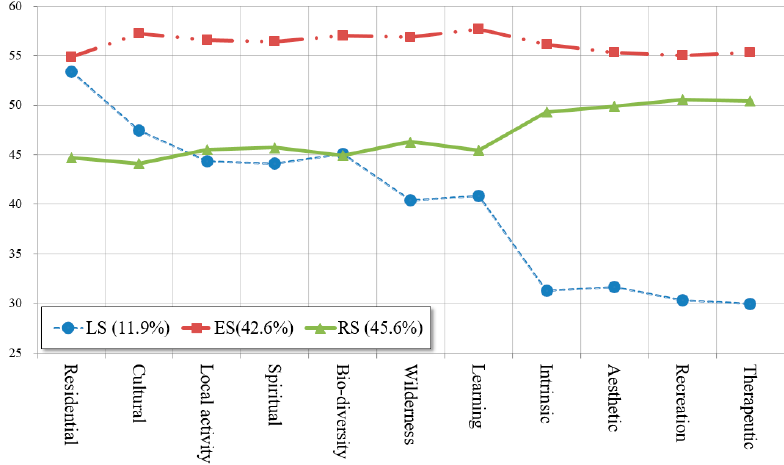
Figure 2. T -scores of place value for each profile.